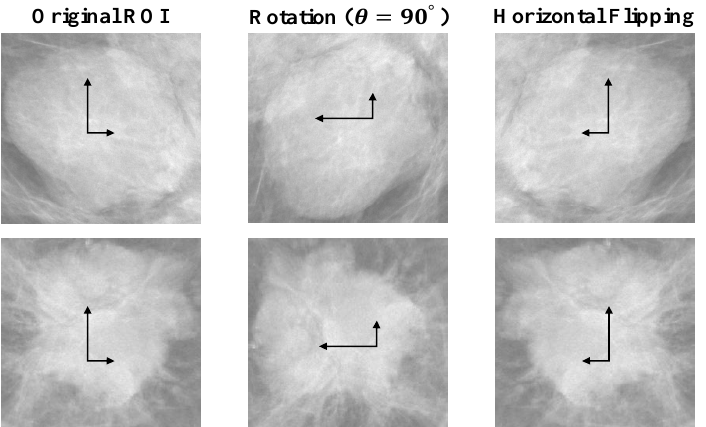
Figure 3. Random sample results after applying the rotation and flipping augmentation methods on the original ROIs. Arrows refer to the direction of the